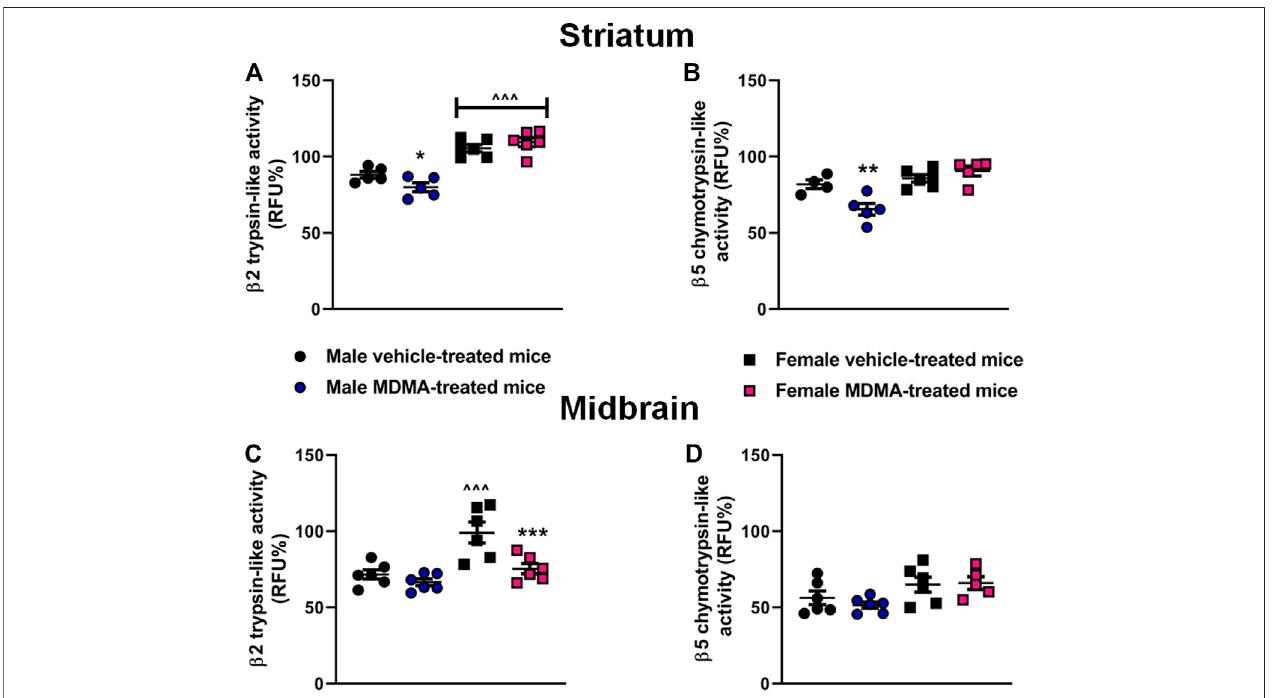
FIGURE 6 | EffectsoftreatmentwithMDMAon β 2trypsin-likeactivityand β 5chymotrypsin-likeactivityinthestriatum (A,B) andmidbrain (C,D) .Adultmaleandfemalemice weretreatedwitheitherMDMA(4 × 20 mg/kg,i.p.2 hapart)orvehicle(salinesolution,i.p.).N (cid:2) 5 – 6micepergroup.Valuesarereportedasmean ± S.E.M.* p < 0.05,** p < 0.01and *** p < 0.001, compared with the respective group of vehicle-treated mice; ∧∧∧ p < 0.001 compared with the respective group of male mice, by Newman-Keuls post-hoc test.